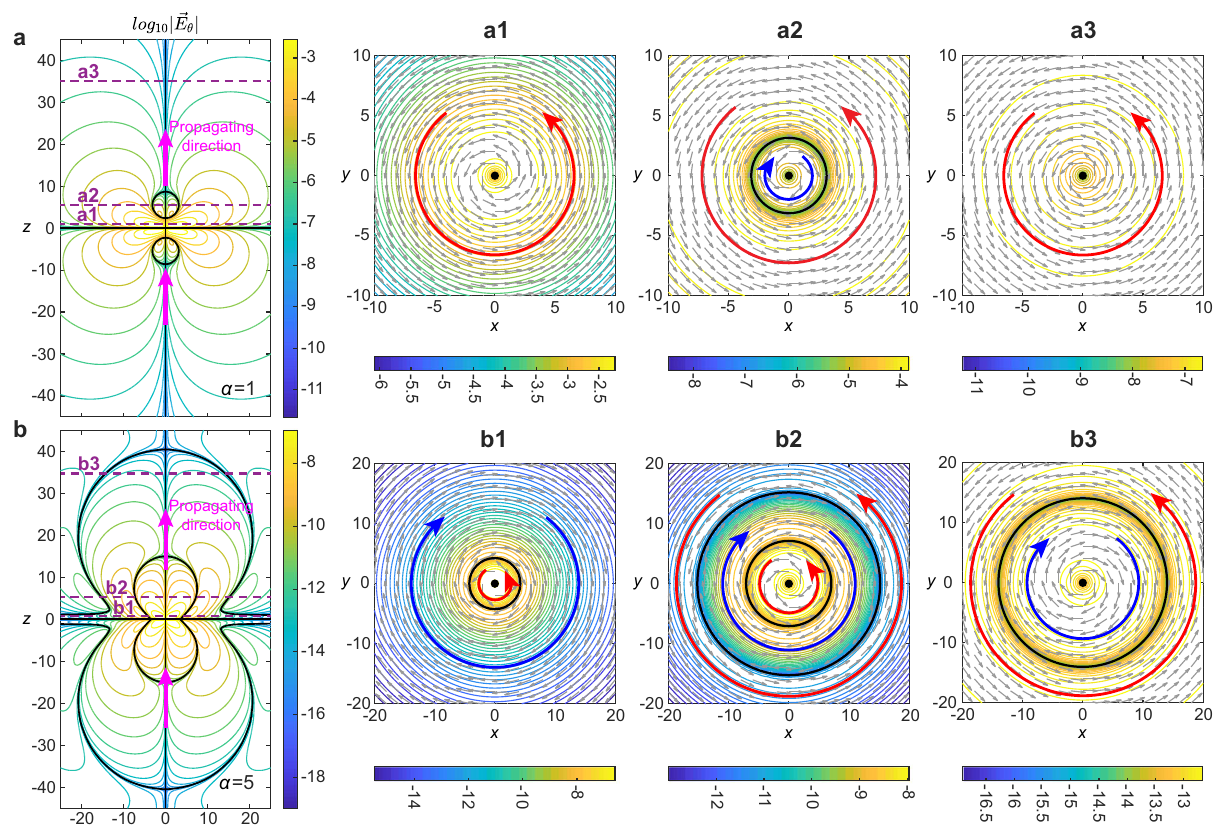
Fig. 2 Electric fi elds of toroidal and supertoroidal light pulses. a , b The isoline plots of the electric fi eld in the x – z plane for a the fundamental TLP, Re[ E θ ( r , t = 0)], and b the STLP of α = 5, Re ½ E ð α ¼ 5 Þ θ ð r ; t ¼ 0 Þ(cid:3) , in logarithmic scale. The bold black lines represent the zero-value singular lines. The dashed purple lines represent the positions of propagation distance corresponding to the transverse plots at right side. Panels a1 – a3 and b1 – b3 show the electric fi eld distributions in the transverse planes. The fi eld magnitude is plotted as contours (in logarithmic scale), while the fi eld orientation is presented by arrow plots. Electric fi eld zeros are marked by the black solid bold lines and black dots. Blue and red arrows represent the two opposite azimuthal directions of the electric fi elds. Unit for coordinates: q 1